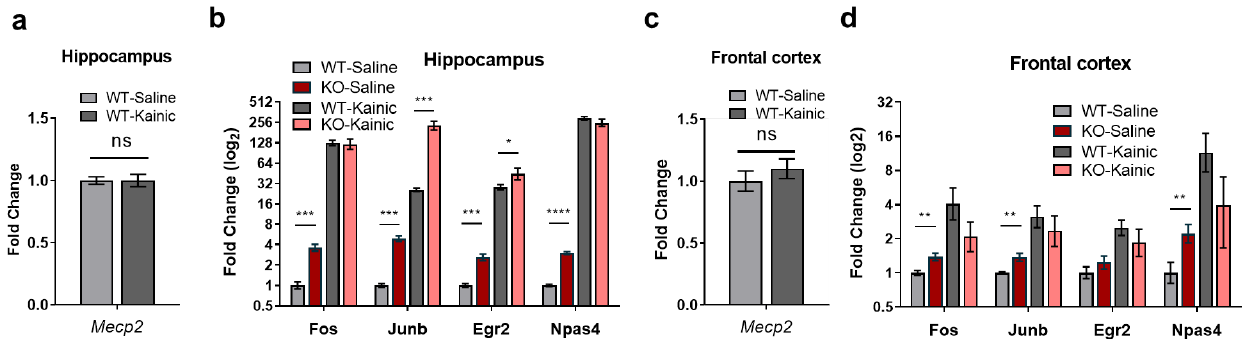
Figure 4. IEGs expression in WT and Mecp2 -KO, 8-week mice following kainic acid (KA) admin- istration. ( a , c ) Mecp2 transcript levels in the hippocampus ( a ) or frontal cortex ( c ) of KA-treated ver- sus untreated WT mice. ( b , d ) Expression levels of Fos , Junb , Egr2 and Npas4 one hour after KA ad- ministration in the hippocampus ( b ) or frontal cortex ( d ) of WT and Mecp2 -KO mice ( n = 5 – 6 animals for each condition, graphs represent means ± SEM, * p < 0.05, ** p < 0.01, *** p < 0.001 and **** p < 0.0001 in Student’s t -tests).